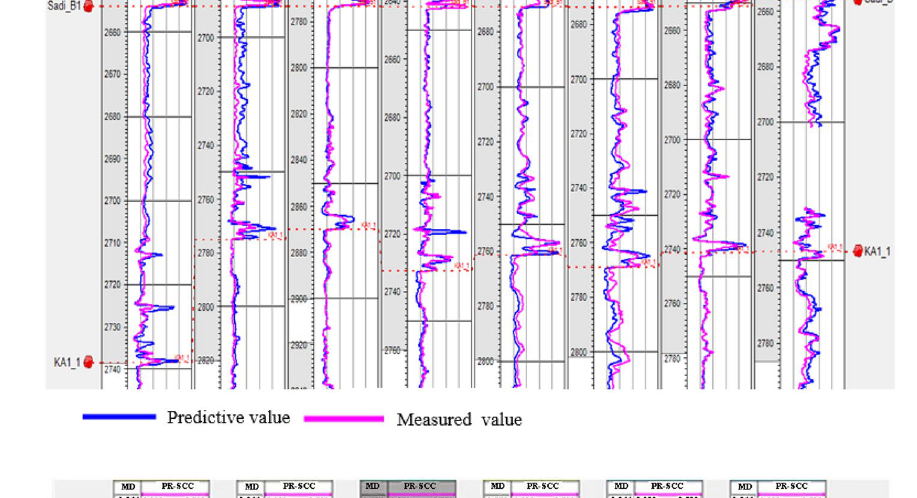
Fig. 7 Comparison between cal- culated and measured dynamic Poisson's